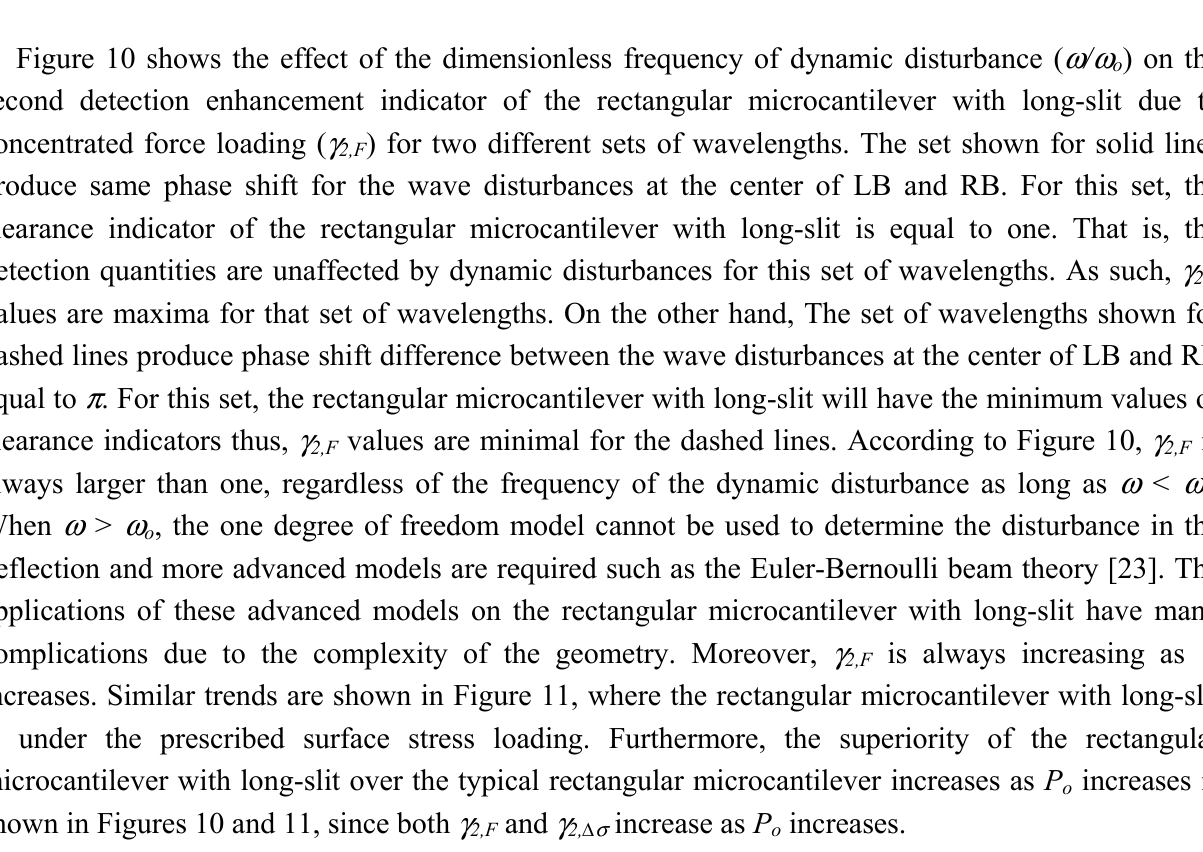
Figure 9. Effects of the dimensionless dynamic disturbance wavelength ( λ / W ) and the second dimensionless dynamic disturbance force amplitude { P the second detection enhancement indicator of the rectangular microcantilever with long- slit due to prescribed surface stress loading ( γ